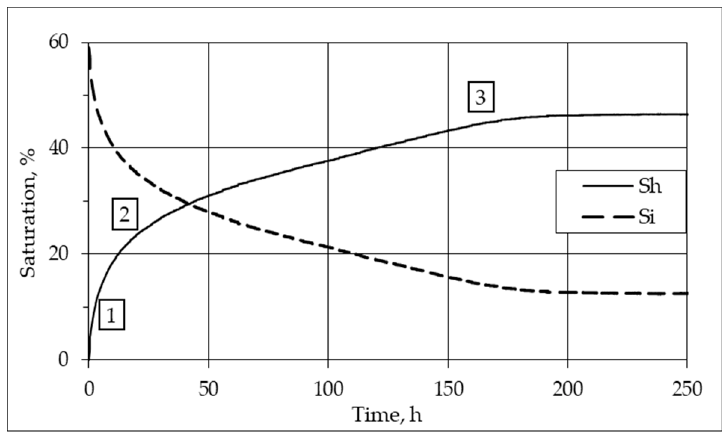
Figure 4. Time-dependent methane hydrate and ice saturations ( Sh and Si , respectively) in sample silt 2 ( W = 20%, Si = 59%) at t = −2.5 °C.